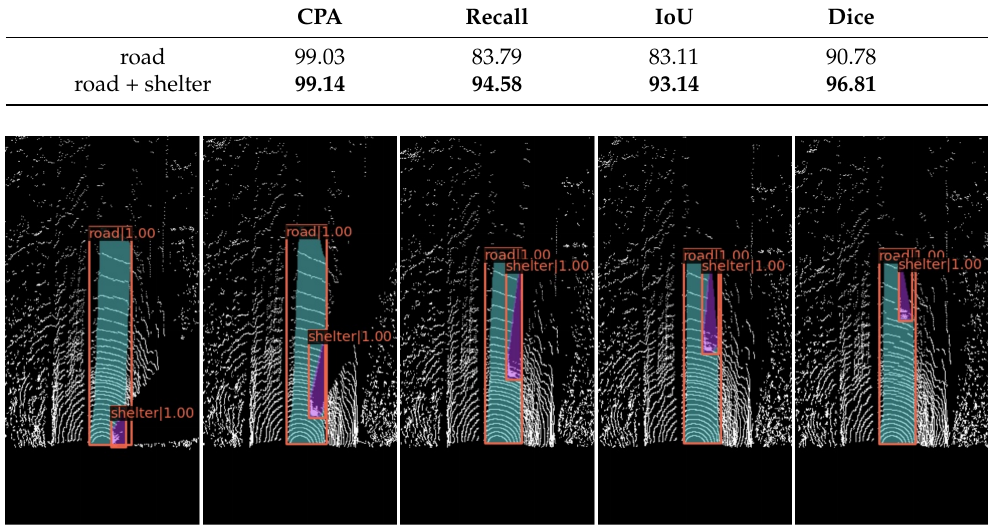
Table 4. Compare results before and after adding the shelter mask.